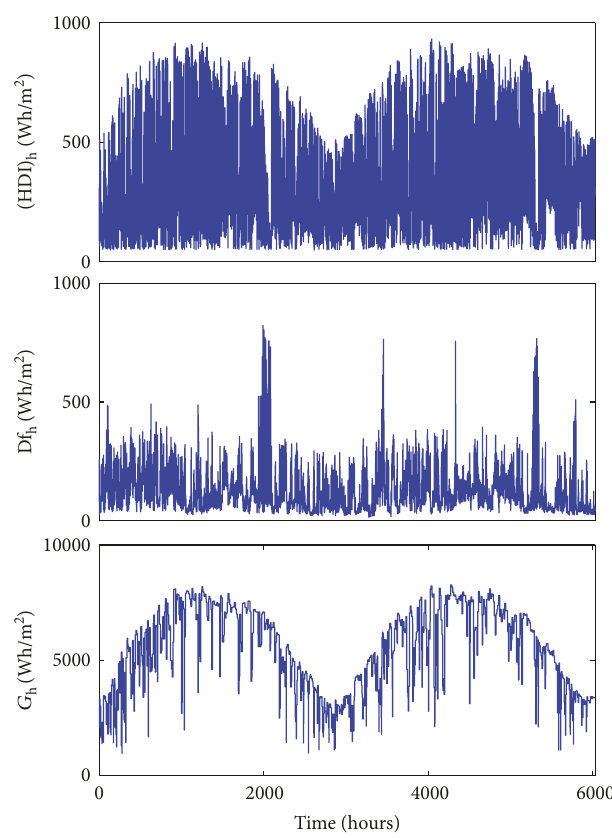
Figure 3: Hourly direct, di ff use, and global solar radiation for 2010 and